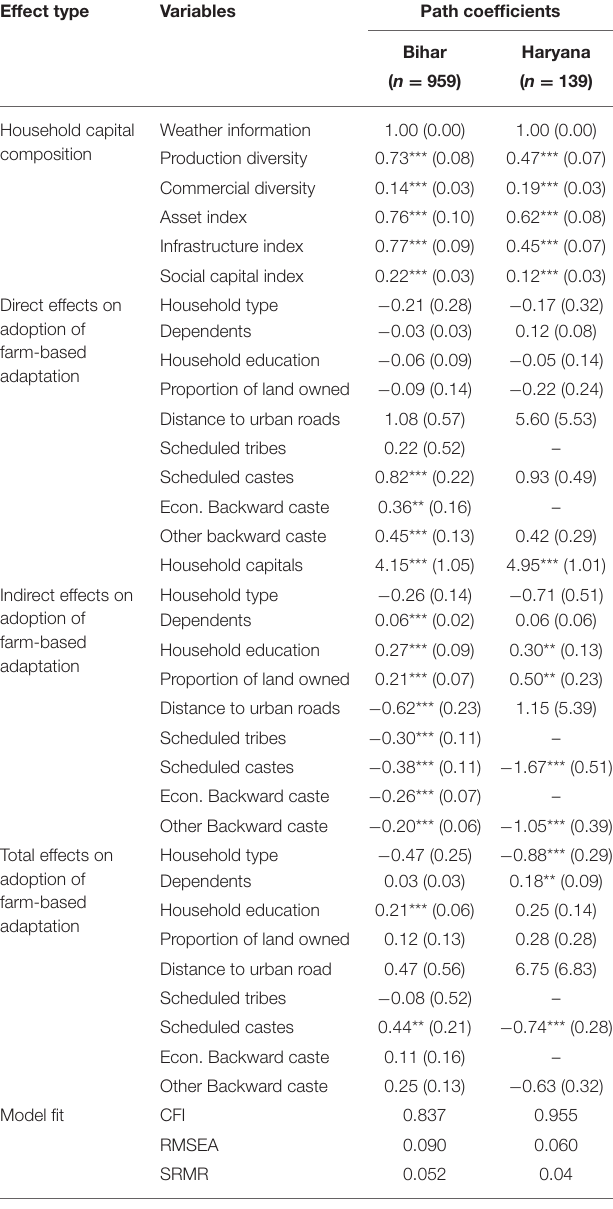
TABLE 7 | SEM results for farm-based adaptation strategies in Bihar and Haryana. Effect